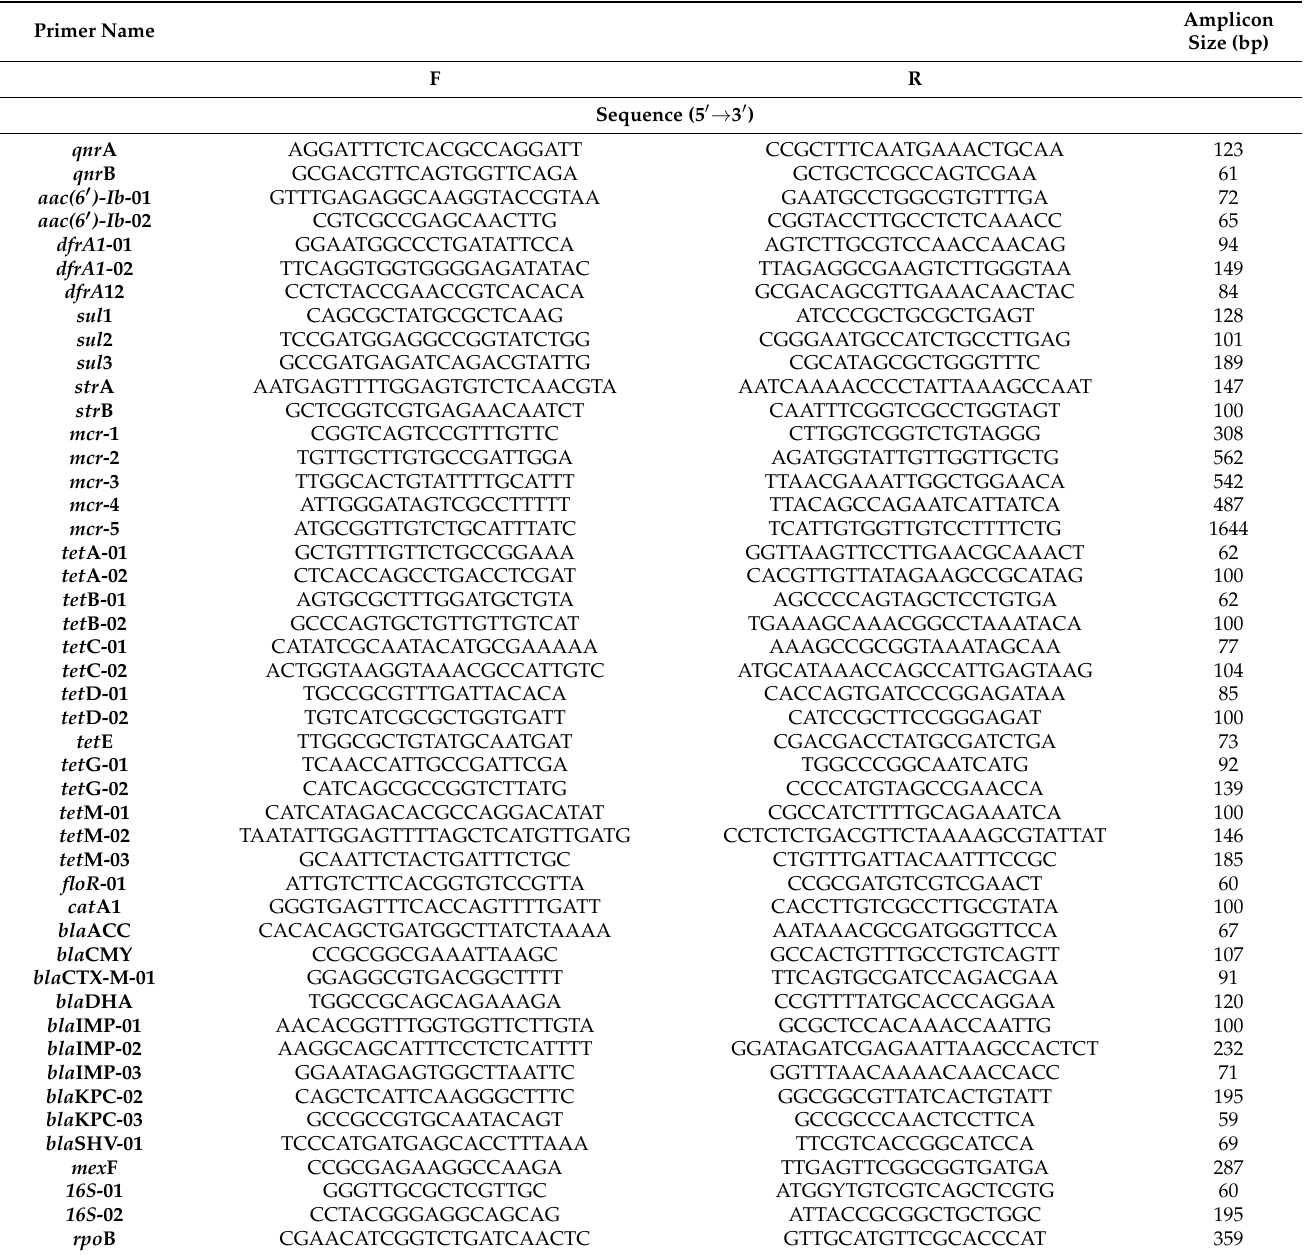
Table 1. Primers used for PCR amplification. F: forward, R: